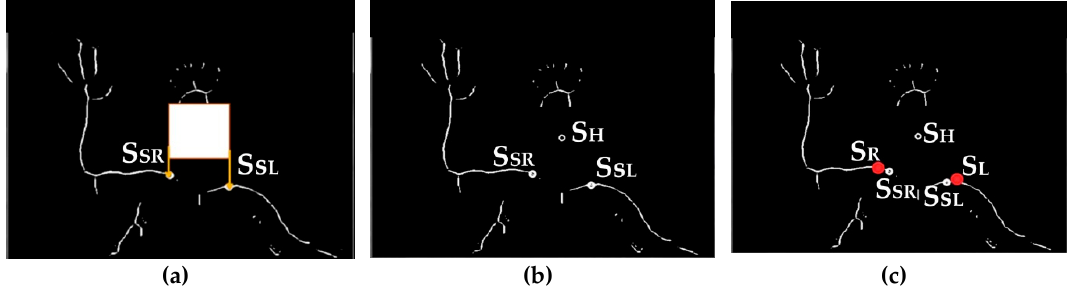
Figure 12. The shoulder point search process: ( a ) The initial shoulder point is sought under the square region ( b ) The initial shoulder points ( c ) The actual shoulder points.